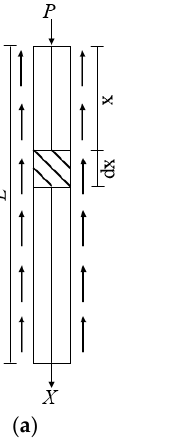
Figure 9. Diagram of force analysis of I-shaped steel. ( a ) Force diagram of detached body; ( b ) Force diagram of element body.